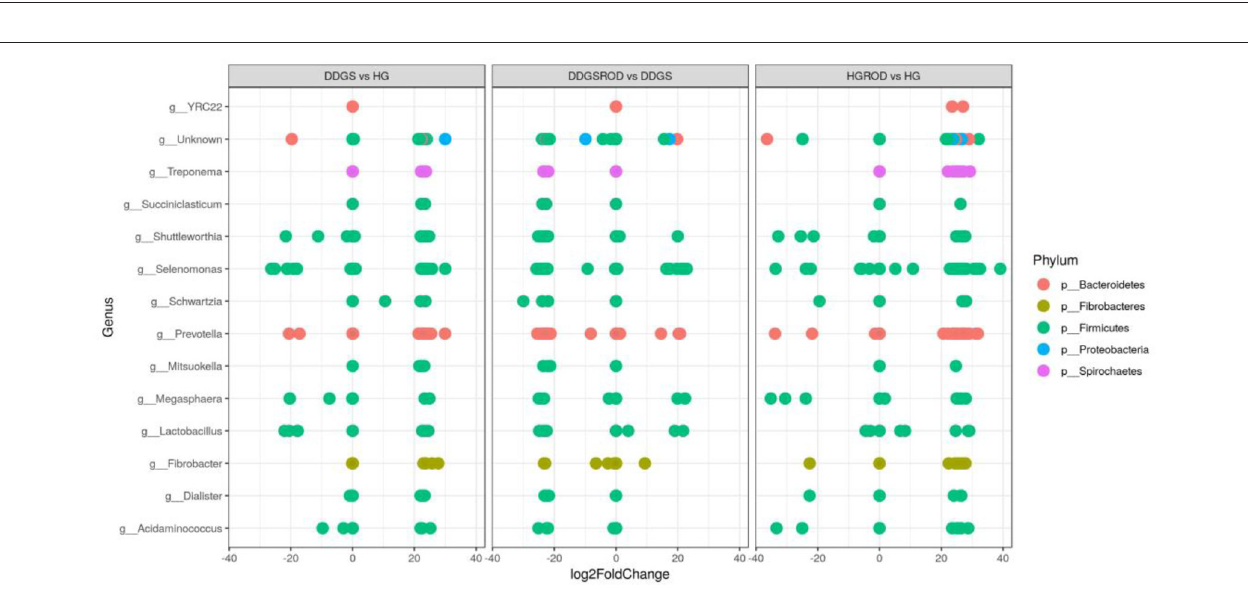
FIGURE 4 | Effect of different treatments on the RA of the ruminal microbial community at the genus level. Treatments were as follows: wheat DDGS diet without adding the ROD extract; DDGS&ROD (wheat DDGS diet with ROD extract); HG (basal diet without adding ROD extract); and HG&ROD (basal diet with ROD extract).